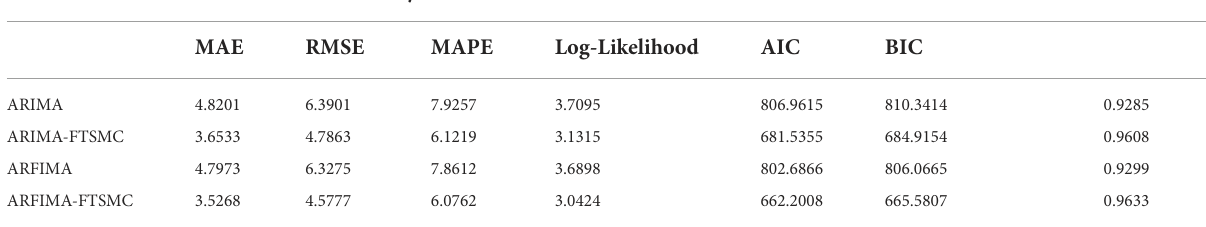
TABLE 10 The comparison of the ARIMA model with GARCH, FFNN, and GARCH-FFNN using model accuracy, the best model selection, and goodness of fit R 2 . Model Model